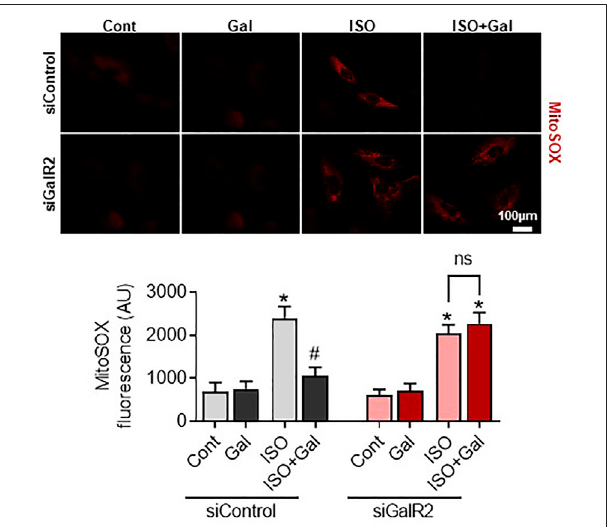
FIGURE 5 | Galanin dictates cell hypertrophic responses via GalR2. Representative images and cell surface quanti fi cation of H9C2 cardiomyoblasts transfected with control siRNA (siControl) or GalR2 siRNA (siGalR2) under isoproterenol-induced stress (ISO). Data represents the mean ± SEM from three independent experiments. * p < 0.05 vs. control; # p < 0.05 vs. ISO.